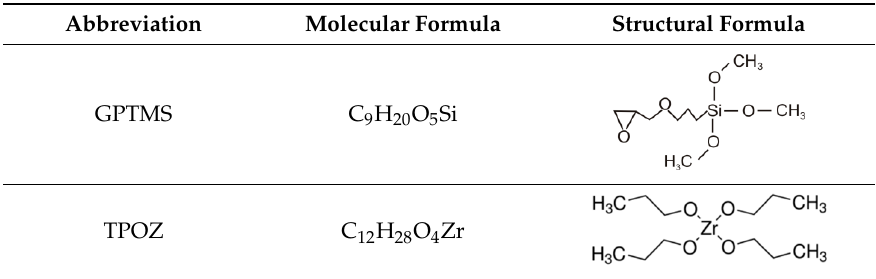
Table 1. Precursors for the preparation of AC 130-2 sol–gel [25,27].